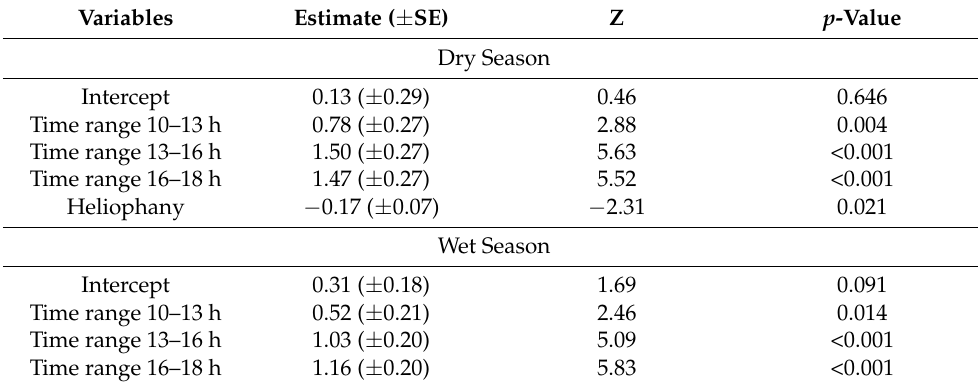
Table 2. Results of the best candidate models explaining the number of individuals of Stenocercus iridescens for the dry and the wet season